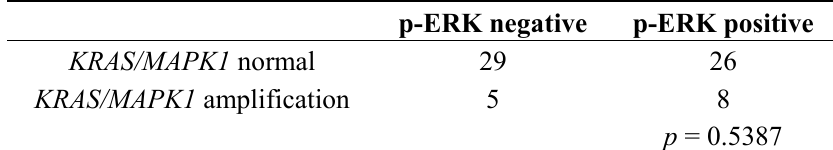
Table 1. Association between KRAS/MAPK1 amplification and p-ERK expression.